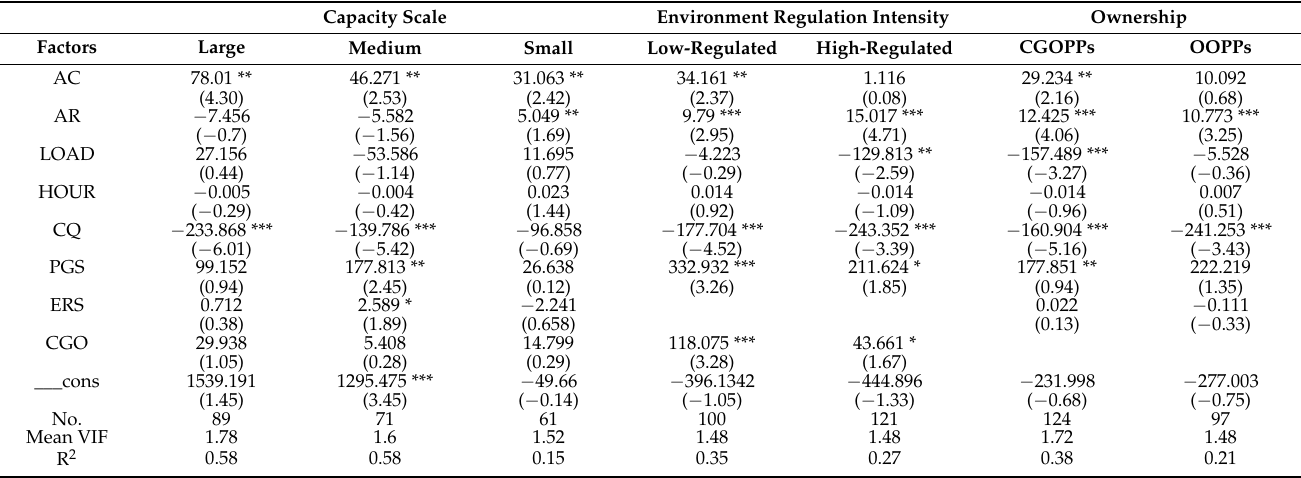
Table 6. Heterogeneity analysis of influencing factors on MACs of SO 2